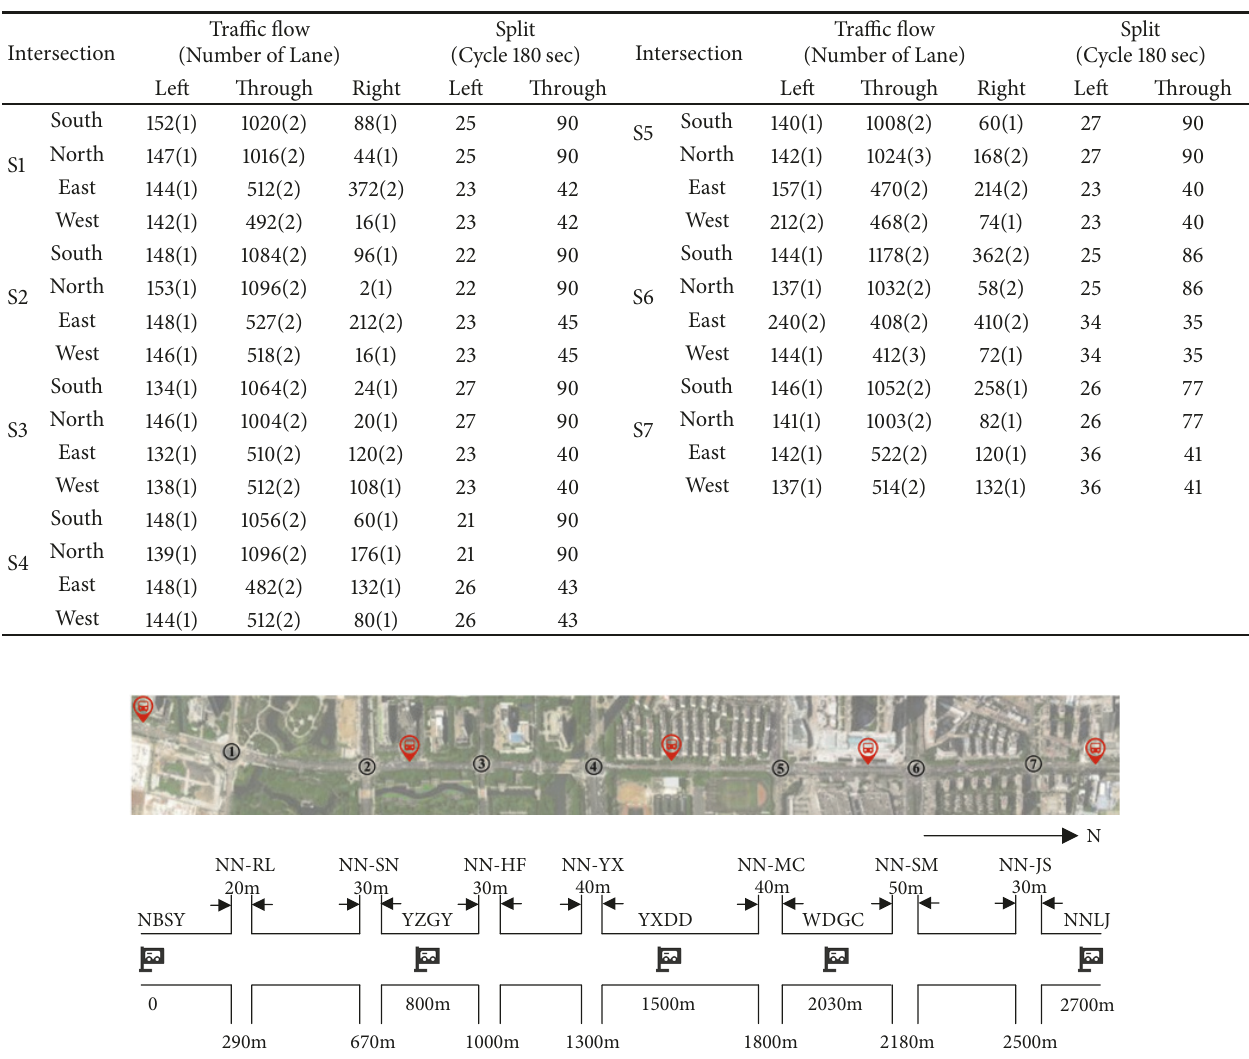
Table 7: Traffic volume and signal timings at intersections along the Ningbo tramline.